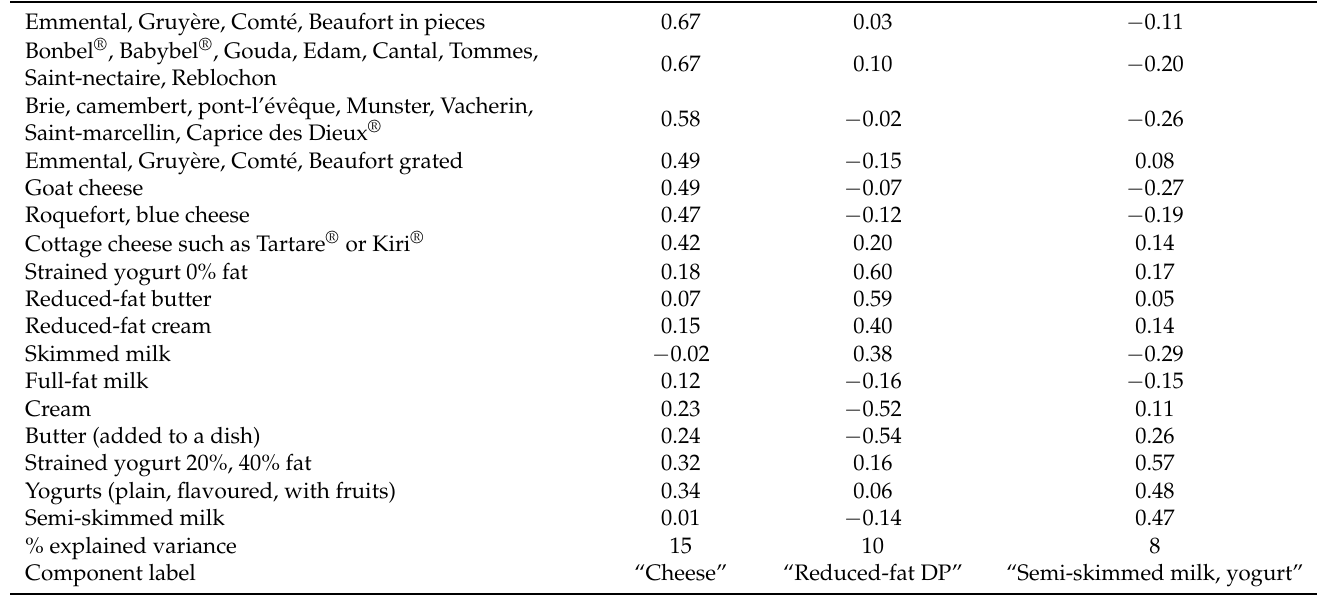
Table 1. Factor loadings on each maternal DP consumption patterns from principal component analysis ( n =